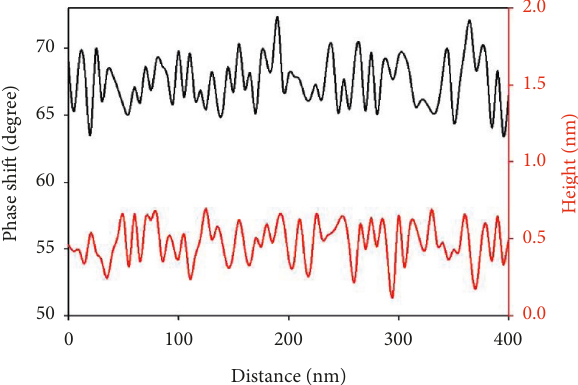
Figure 2: Linear scanning of phase shift and topography in the same position for ZrCuAl.